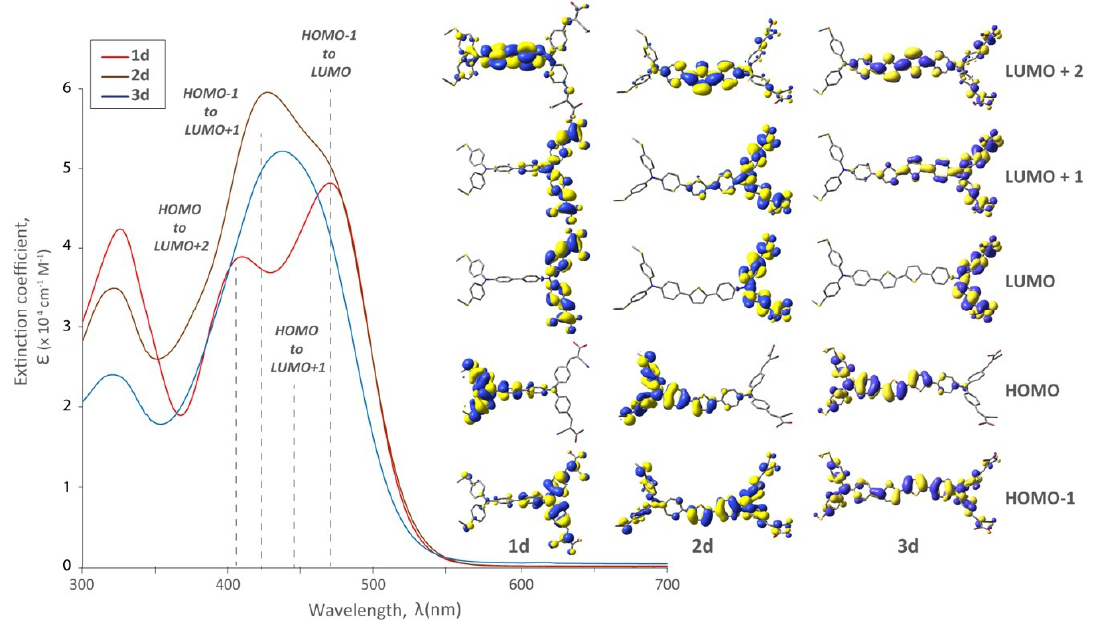
Figure 4. UV-Vis spectra and relevant molecular orbitals of bichromic/bipodal dyes ( 1d , 2d , 3d ). The effect of extending the π-spacer on the distal TPA while holding the distal substitution constant with -SMe. This distal modification was chosen judiciously because these dyes produced the highest performing DSSCs ( vide infra ).